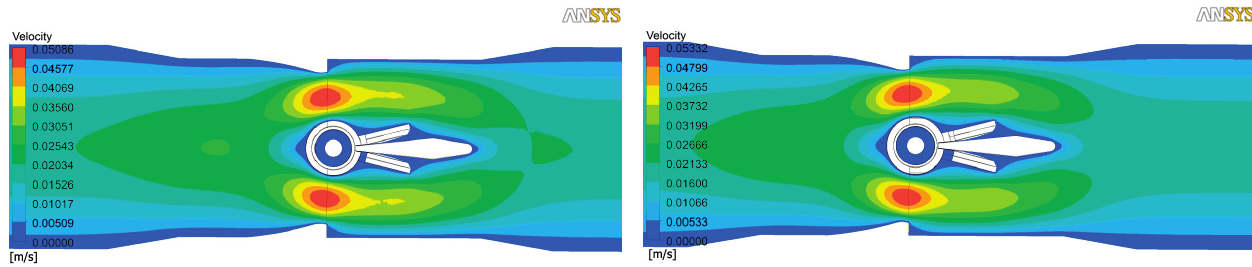
Figure 4. Streamlines of the velocity on the symmetry plane. ( a ) the initial CAD valve design; ( b ) the multi-photon polymerization (MPP) fabricated one.